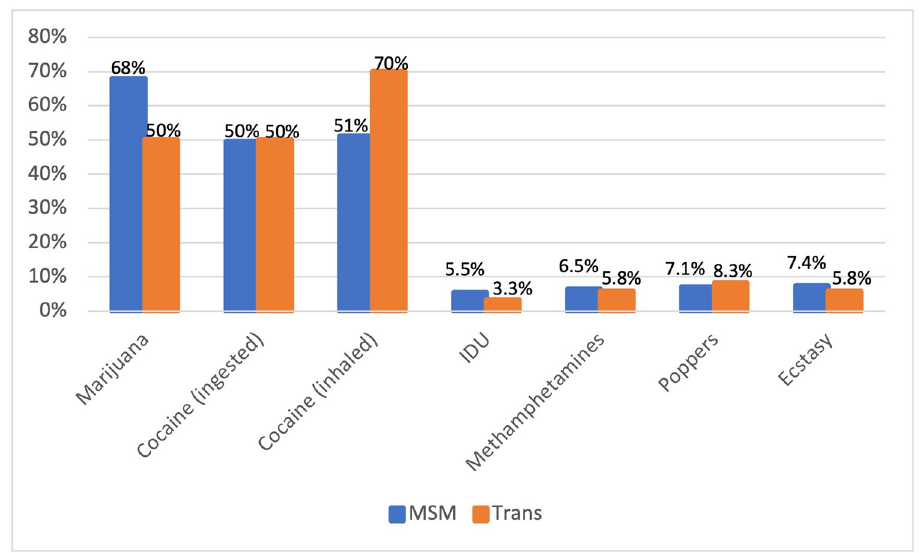
Fig 1. Illegal drug use by transwomen versus men who have sex with men (N =